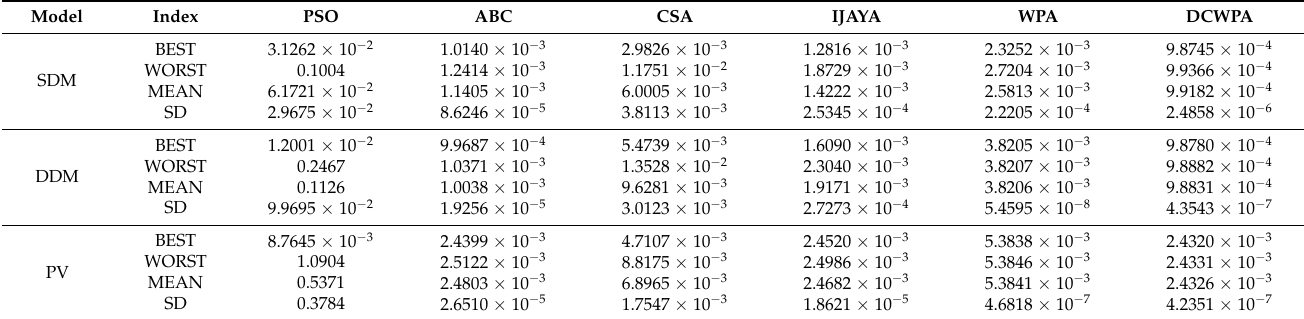
Table 7. Solution results of three models by different